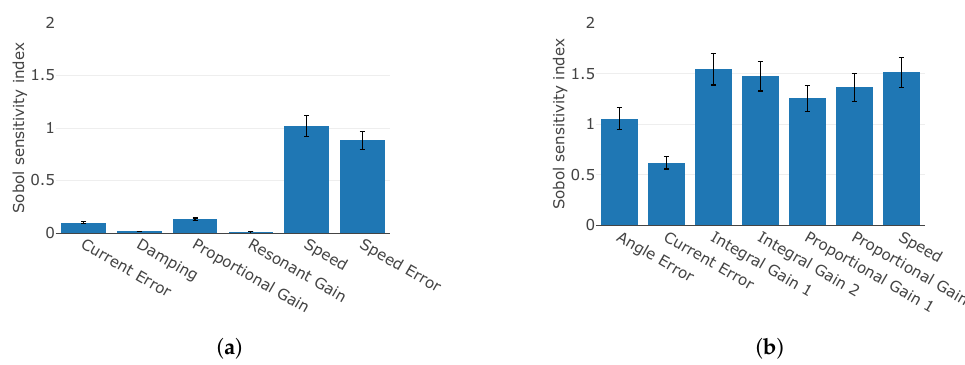
Figure 7. Results of the case study: ( a ) sensitivity analysis for resonant control, ( b ) sensitivity analysis for VSD control.